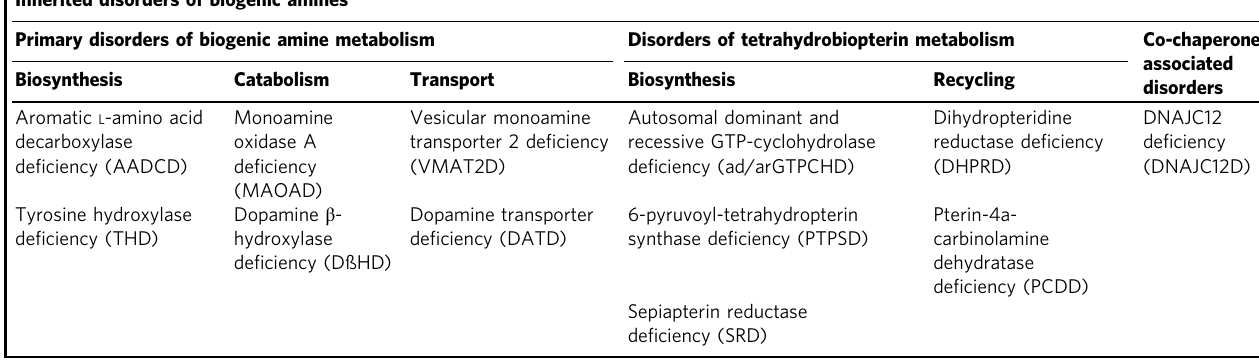
Table 1 Classi fi cation of inherited disorders of biogenic